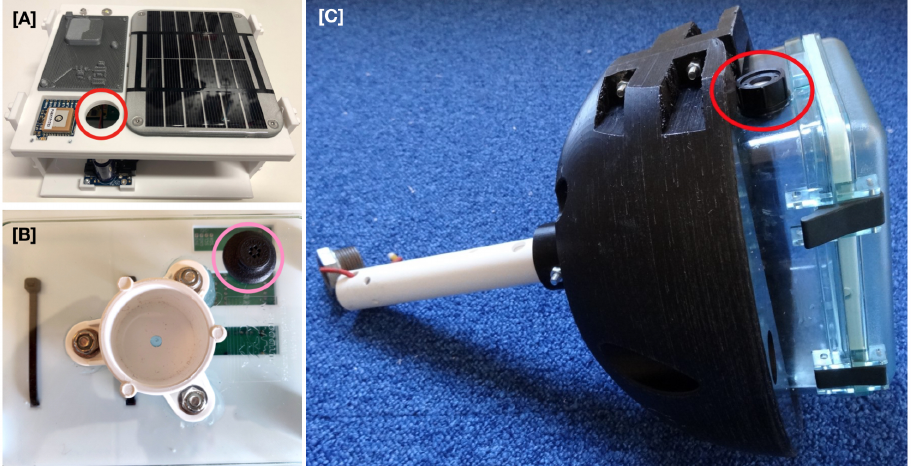
Figure 4. ( A ) The top plate of the 3D printed frame was modified to include a hole for the threaded vent (red circle). ( B ) A snap-in vent was installed on the bottom of the Lexan case (pink circle). ( C ) M16 threaded liquid tight vent (red circle) installed on the side of the Lexan